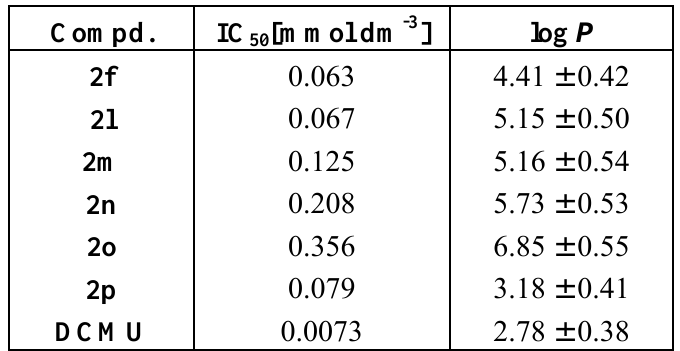
values concerning inhibition of chlorophyll production in green algae Chlorella Table 2. IC 50 vulgaris by the tested anilides 2f , 2l , 2m , 2n , 2o and 2p and calculated log P values of the compounds in comparison with standard DCMU (see